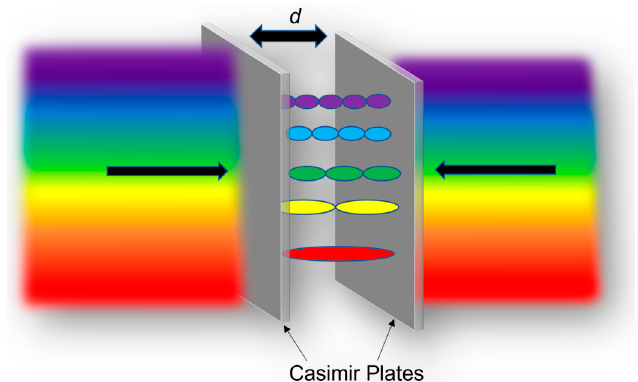
Figure 1. Schematic of the attracting net force arising between two identical uncharged conducting